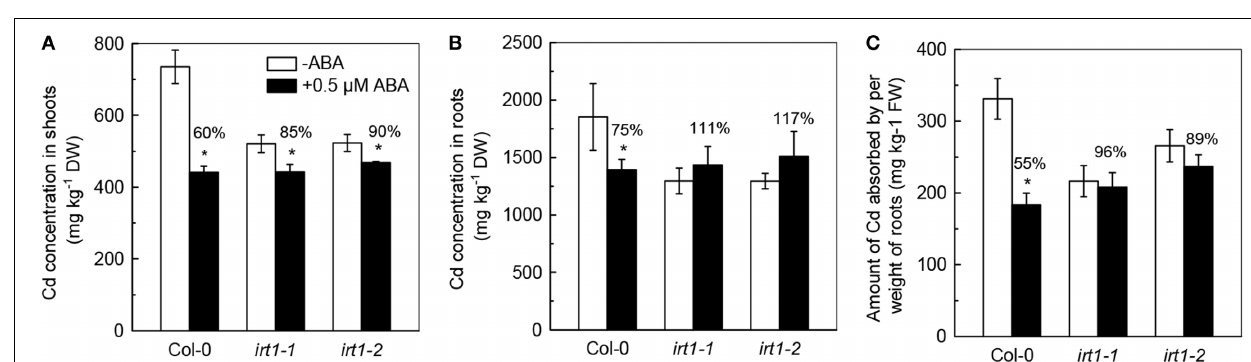
FIGURE 7 | Effects of ABA on Cd concentration and Cd uptake in Col-0 plants and the irt1-1 and irt1-2 mutants. Plants were grown in 10 µ M Cd-added nutrient solution containing 0 ( − ABA) or 0.5 µ M ABA for 7 days. The Fe level in the nutrient solution was 25 µ M. (A) Shoot